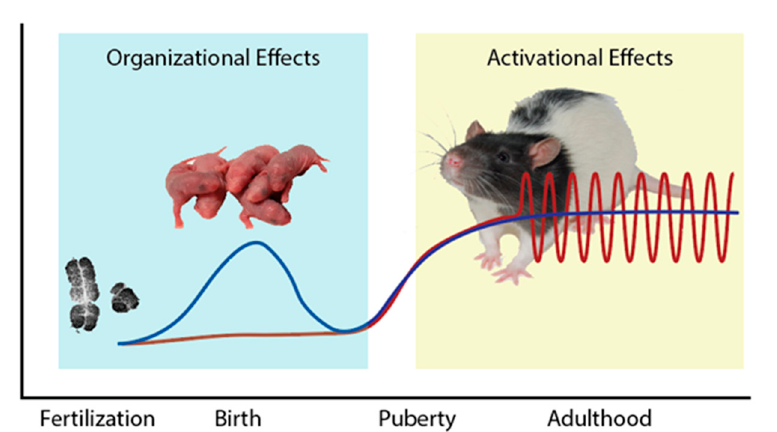
Figure 3. Endocrine changes associated with life stages in the rat. A surge in testosterone (blue line) occurs during the perinatal period in male rats, causing many organizing effects. Levels of estradiol (red line) are relatively low during this time, in both male and female rats. At puberty, however, levels of these hormones begin to rise with levels of testosterone increasing in male rats and levels of estradiol rise in female rats, leading to the activational effects of these hormones in their respective sexes. Levels of testosterone remain relatively stable, whereas levels of estradiol become pulsatile. These organizational-activational effects underlie many sex differences in behavior. Sex chromosome complement, determined at fertilization, also influences several sex differences in the adult rat.